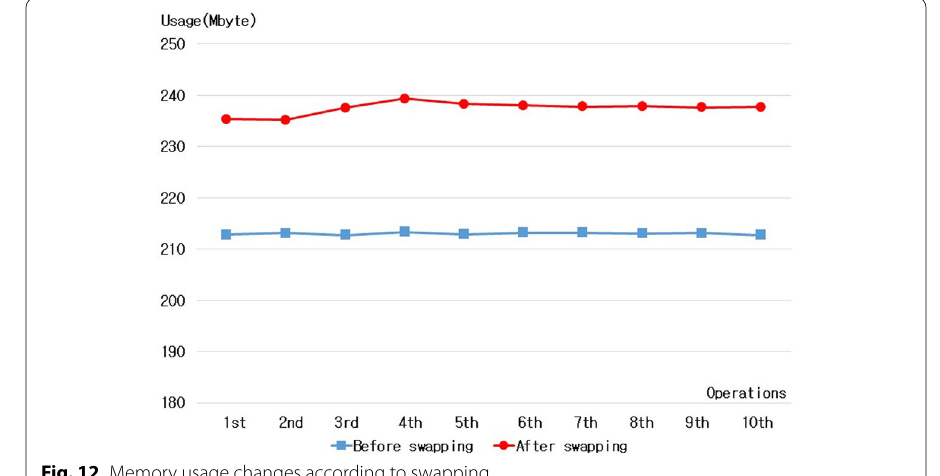
Fig. 12 Memory usage changes according to swapping